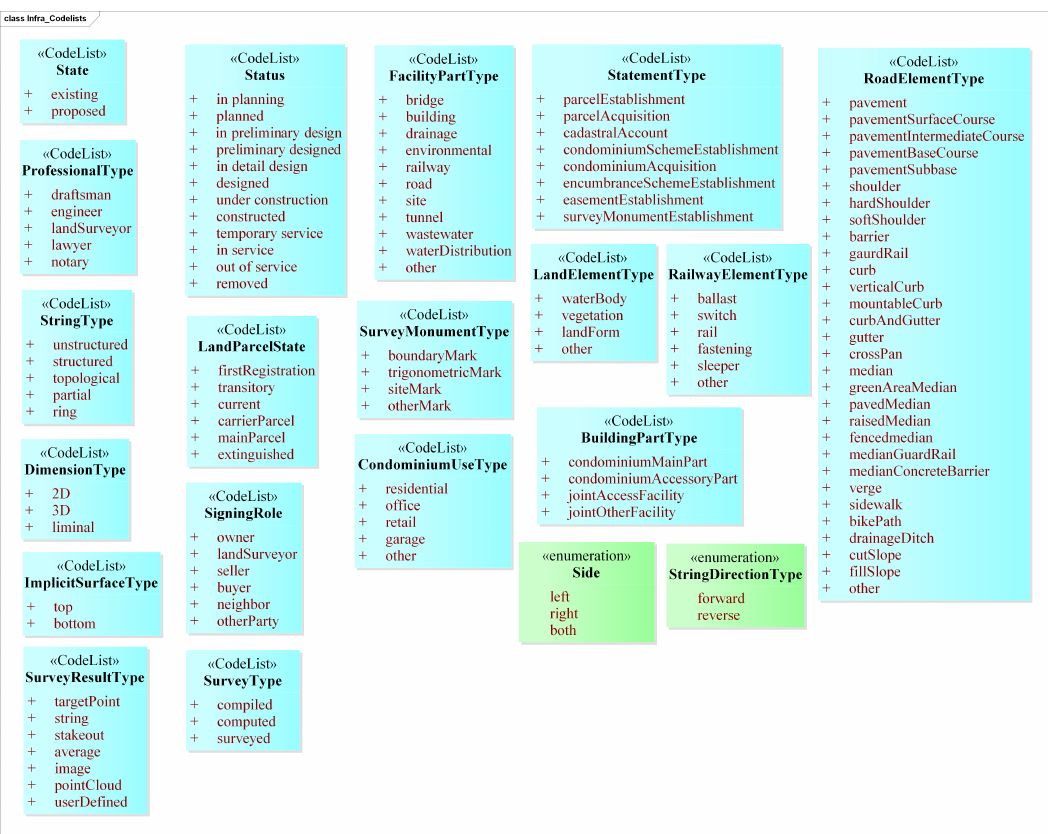
Figure A7. The UML excerpt depicts the LandInfra codelists (and enumerations) implemented in the CityGML Infra